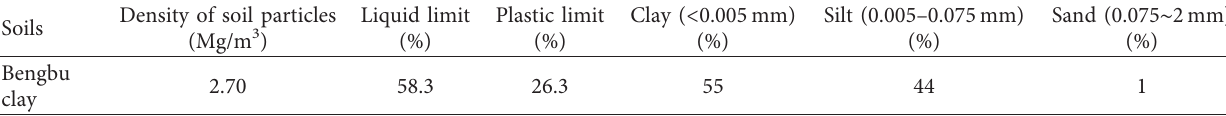
Table 1: Basic physical properties of Bengbu clays.